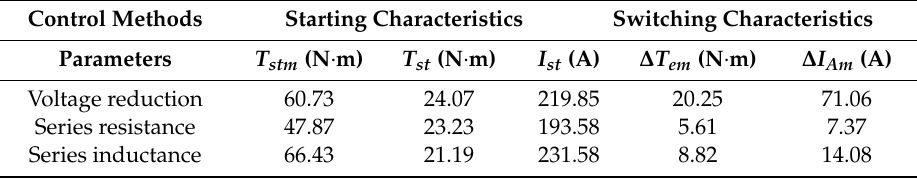
Table 4. Simulation data of starting process by di ff erent step-down